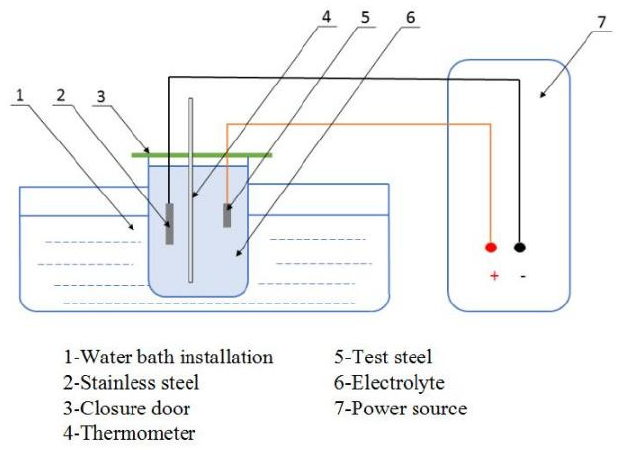
Figure 2. Electrolysis plant.